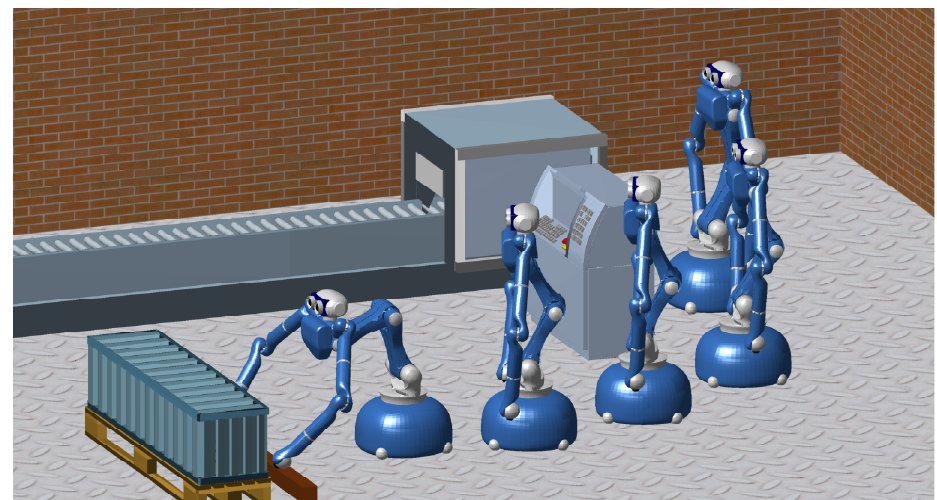
Figure 6. The first phase of the task: move-to-grip.